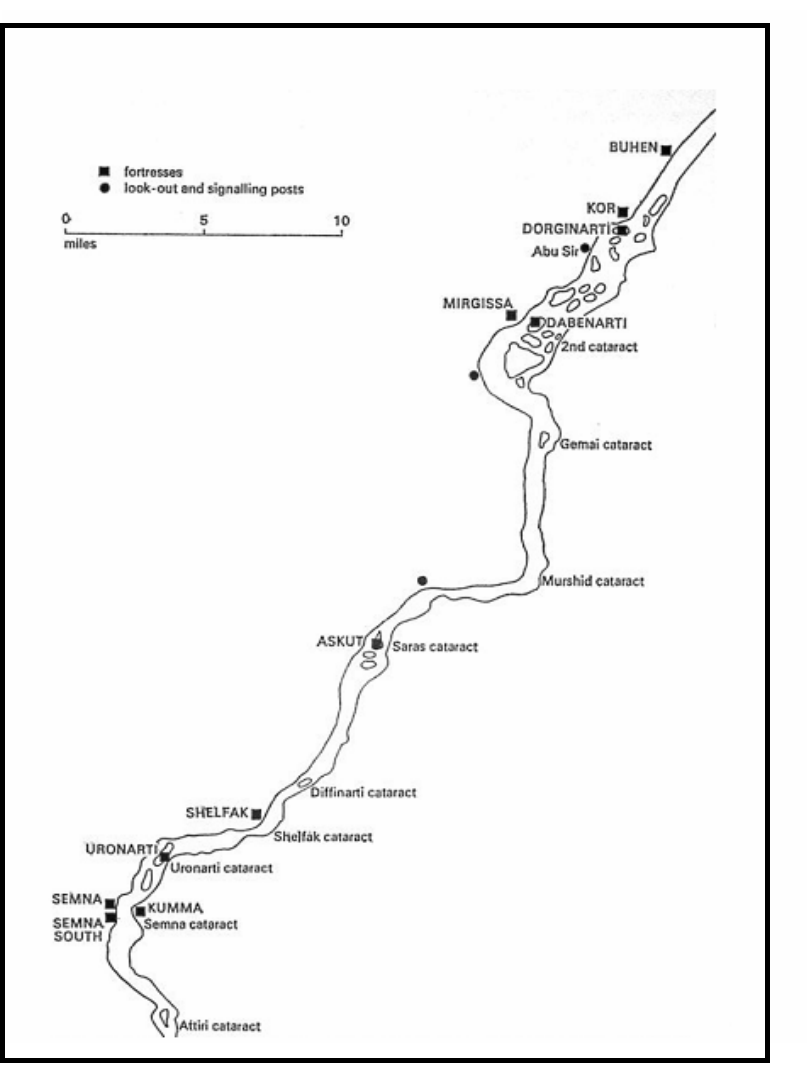
Figure. 1. Map of Lower Nubia Egyptian fortresses and look-out posts (Adams 1977: Fig.